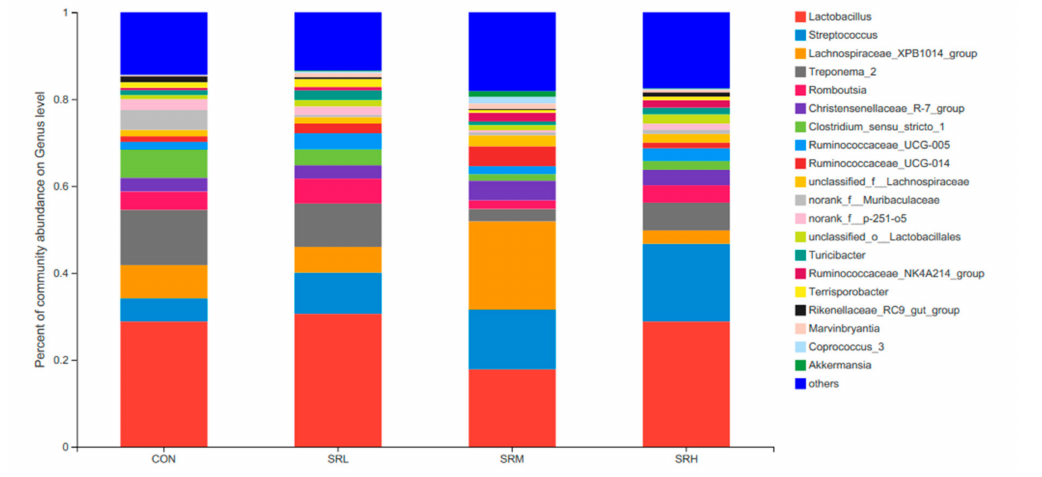
Figure 8. Histogram of the relative genera abundance.